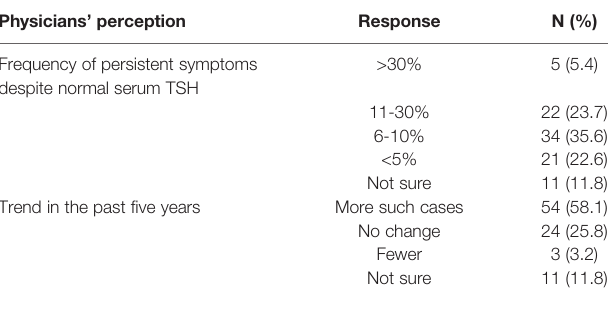
TABLE 3 | Respondents ’ (n = 93) perceptions about persistence of hypothyroid symptoms despite normal serum TSH. 23 did not answer this question. Physicians ’